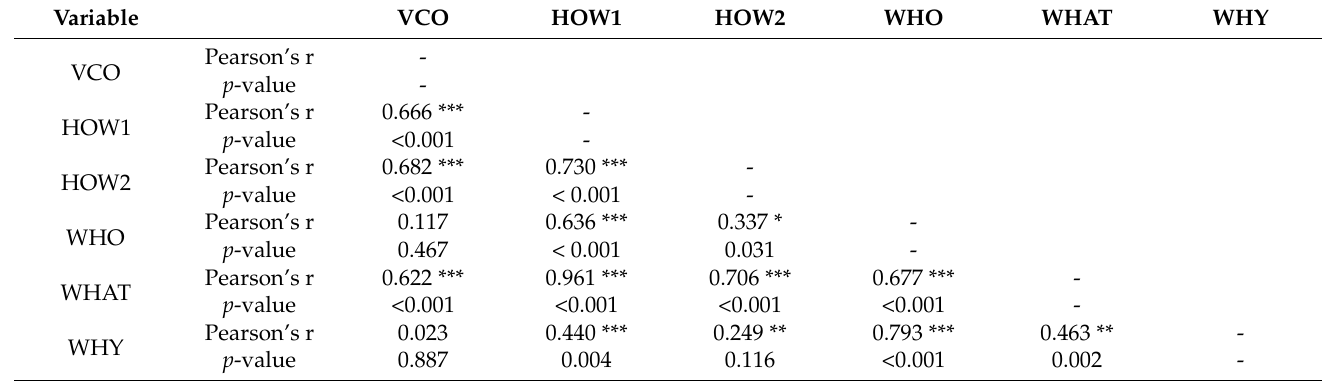
Table 3. Relationships between the elements of the BM